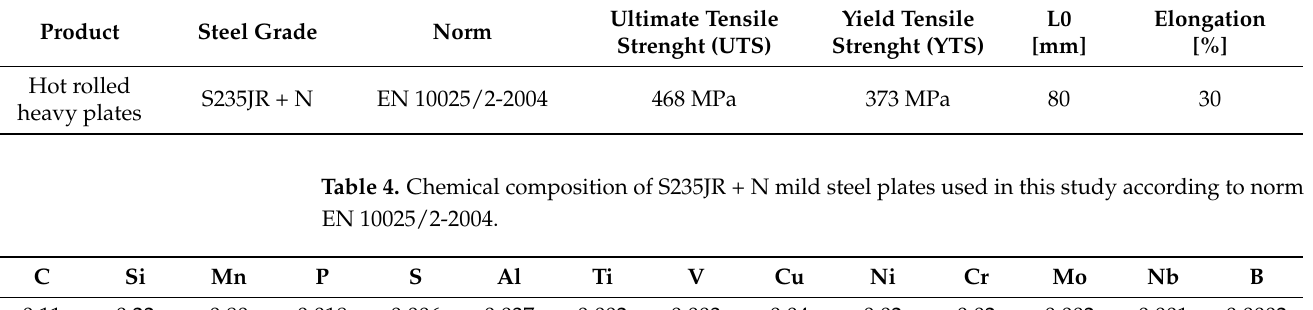
Table 3. Specification and physical properties of S235JR + N mild steel plates used in this study according to EN 10025/2-2004.